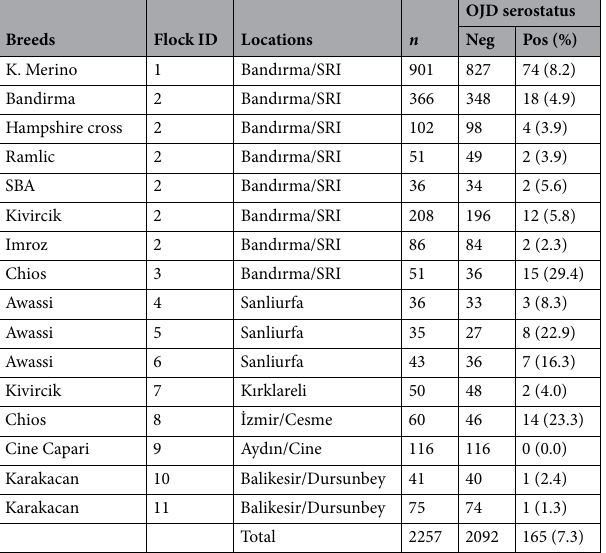
(Fig. 1A and Table S2). Haplotype-phased propeptide variants (diplotypes) were unambiguously assigned for animals that were homozygous, or only had one heterozygous missense variant. In the 221 reference animals,